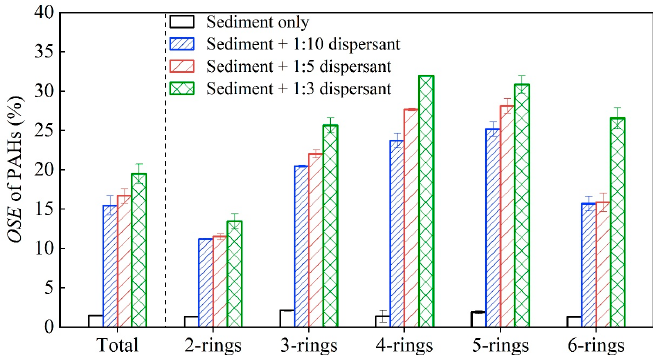
Figure 5. The OSE of PAHs in the sunken oils in the presence of GM-2 and quartz sand.